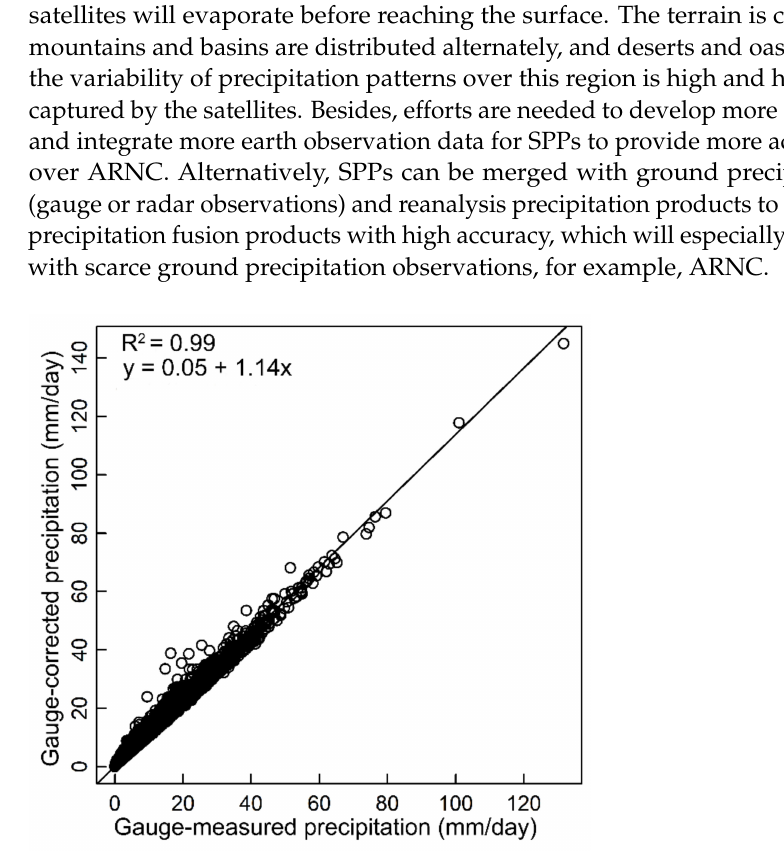
Figure 8. Gauge-measured precipitation versus gauge-corrected precipitation at all weather stations in ARNC for